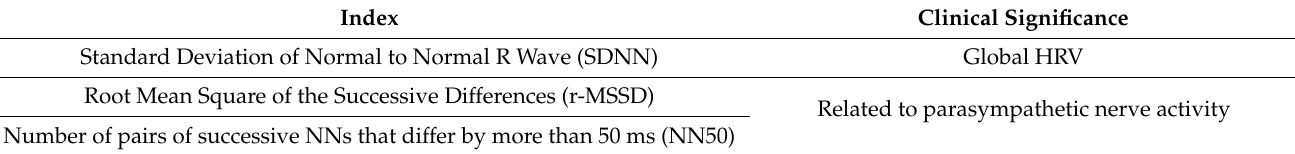
Table 1. HRV parameter